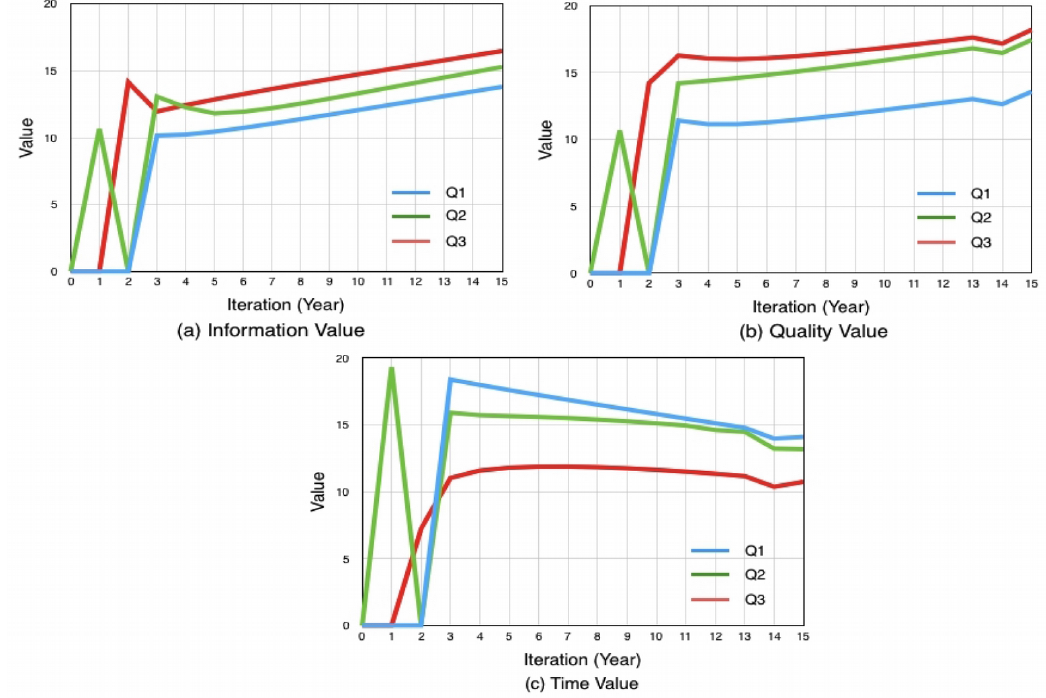
Figure 8. Value Generated in Evaluation Stage: (a) Information Value, (b) Quality Value, and (c) Time